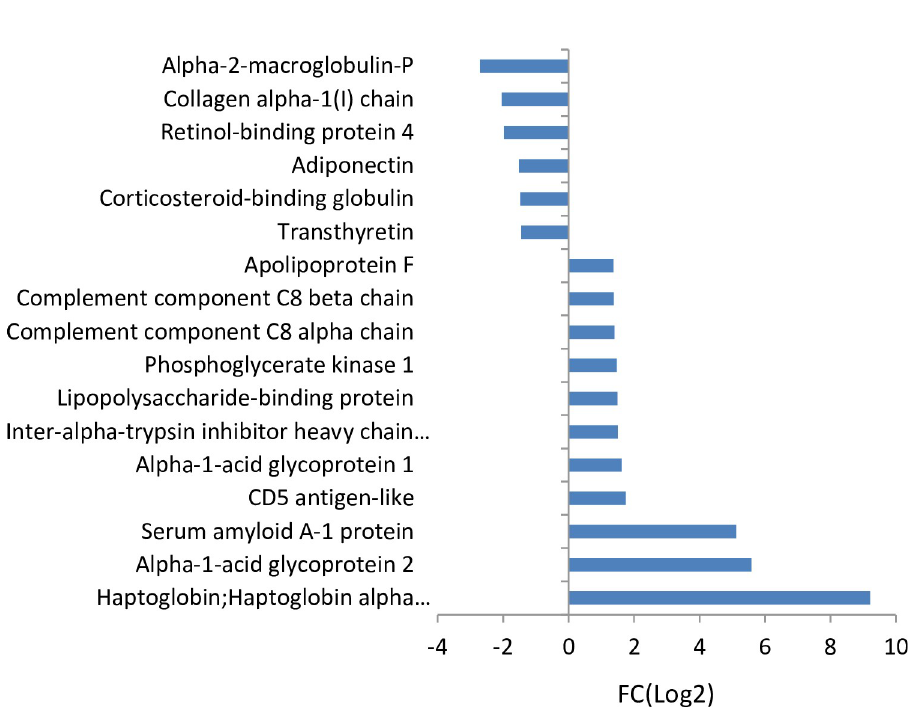
Fig 3. Protein fold changes (FC(Log2) � 1 or � -1) in plasma, metastasis (day 54) versus controls with p- value � 0.05 for Z- and t